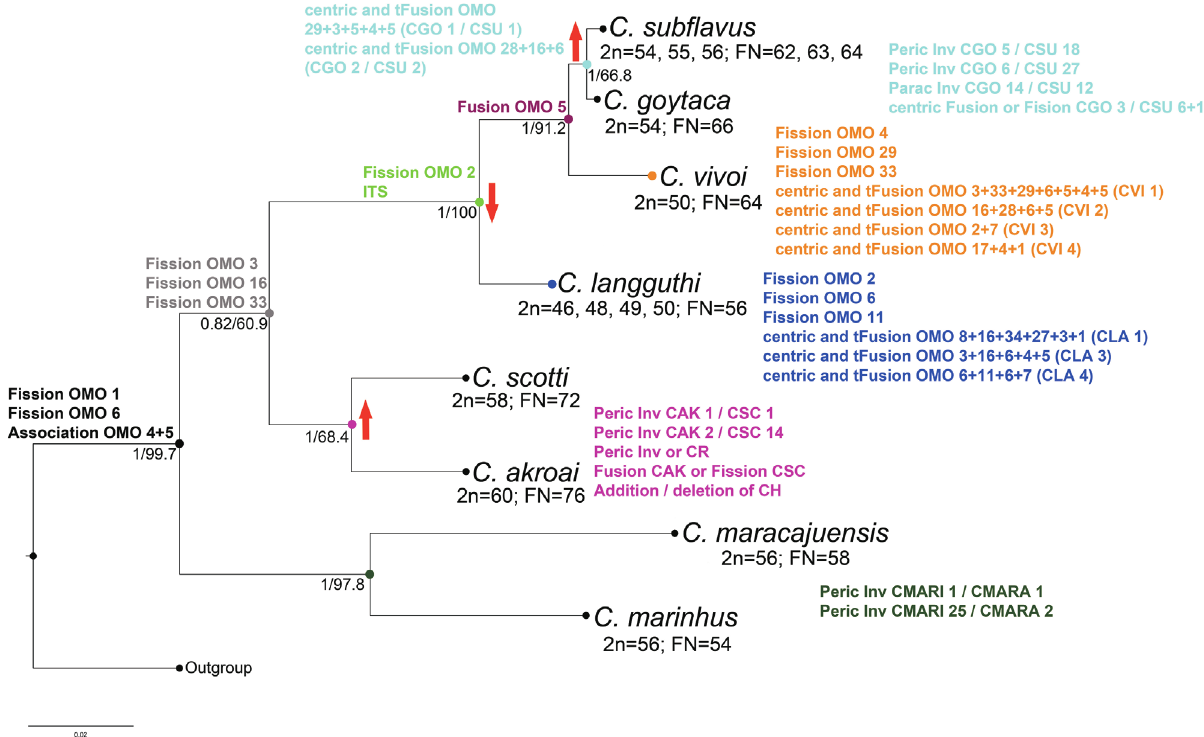
Figure 7 - Phylogenetic relationships of Cerradomys based on cyt- b matrix and Maximum Likelihood (ML) analyses. Values in the nodes represent Bayesian posterior probability and ML bootstrap, respectively. Rearrangements detected by chromosome painting, GTG and CBG-banding are plotted. Arrowsindicateincreaseordecreaseindiploidnumber.Abbreviations:pericentricinversion(pericinv),paracentricinversion(paracinv),centromerere- positioning (CR), constitutive heterochromatin (CH), in tandem fusion (tFusion) and interstitial telomeric signal